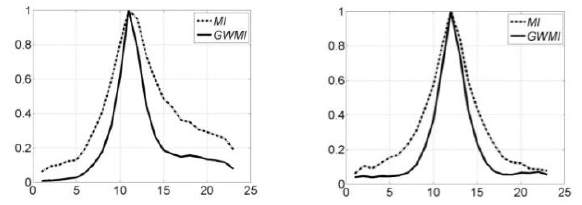
Figure 10. Profile of MI and GWMI peak in X (left) and Y directions (right).